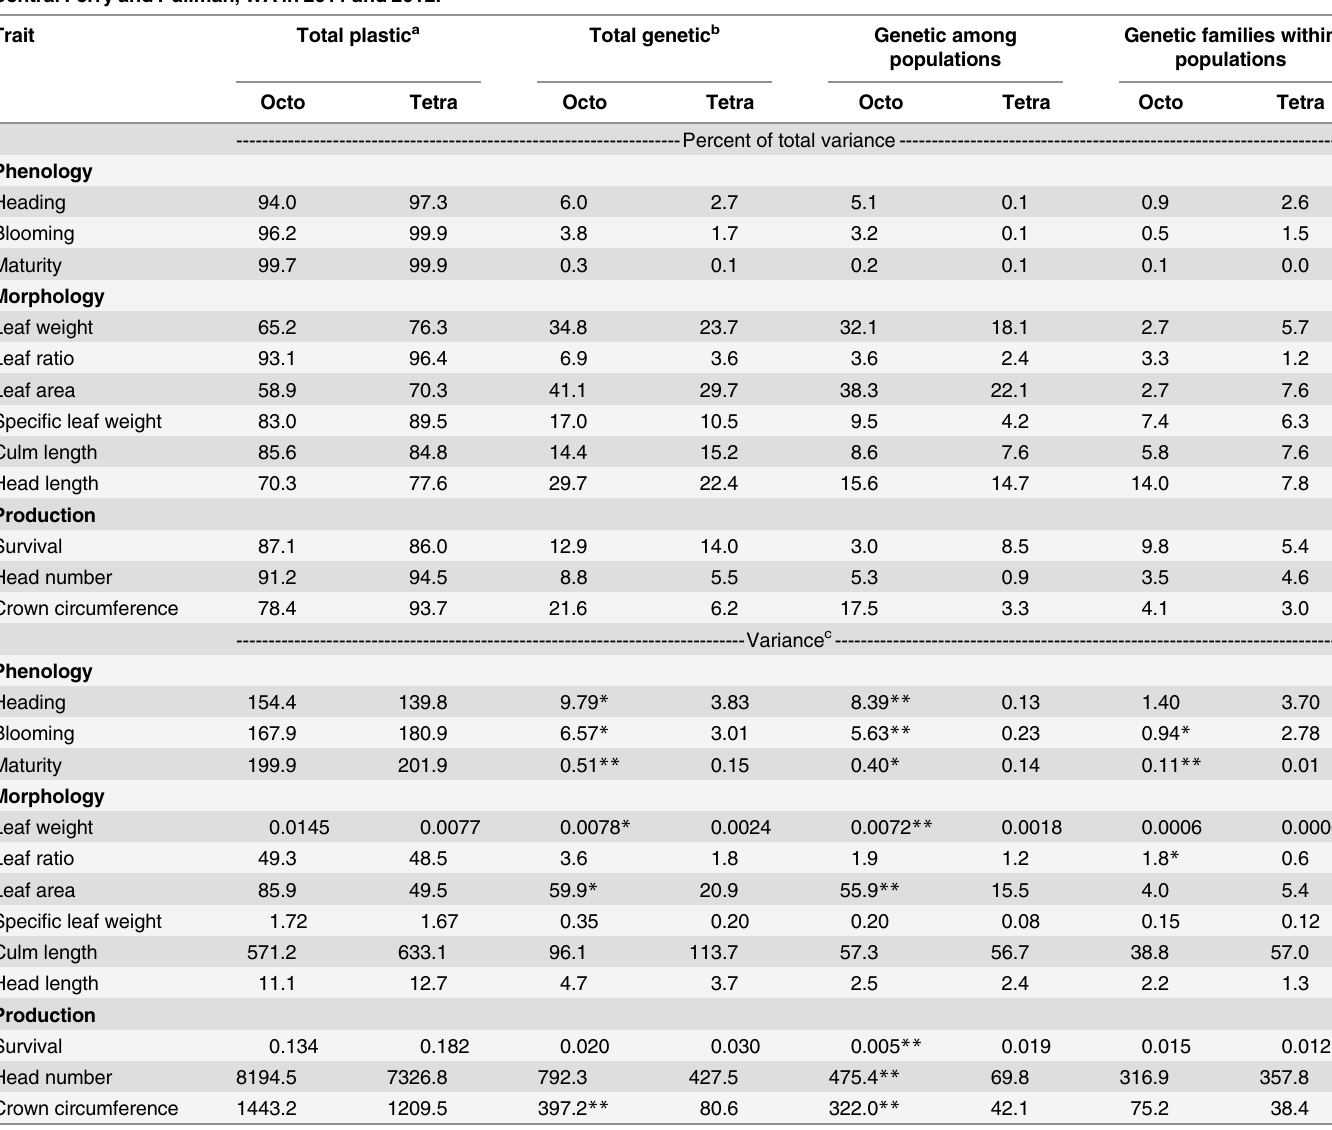
Table 4. Comparisons of octoploid (n = 57) and tetraploid (n = 52) variance components for basin wildrye traits measured in common gardens at Central Ferry and Pullman, WA in 2011 and 2012. Trait Total plastic a Total genetic b Genetic among